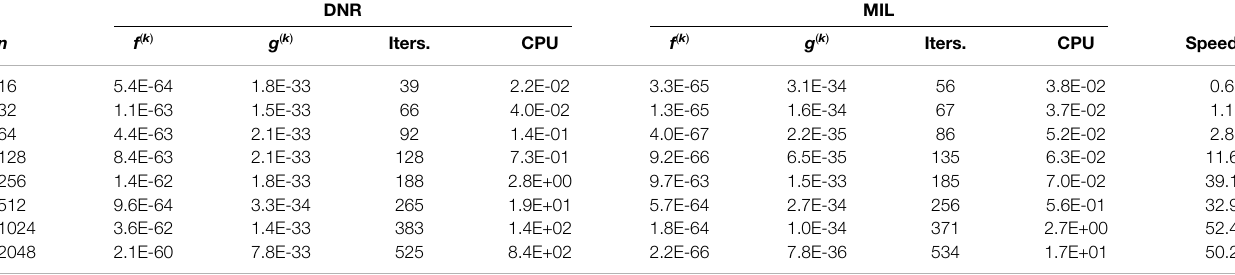
TABLE 4 | Performance comparison of DNR vs. MIL methods testing on Sphere function.